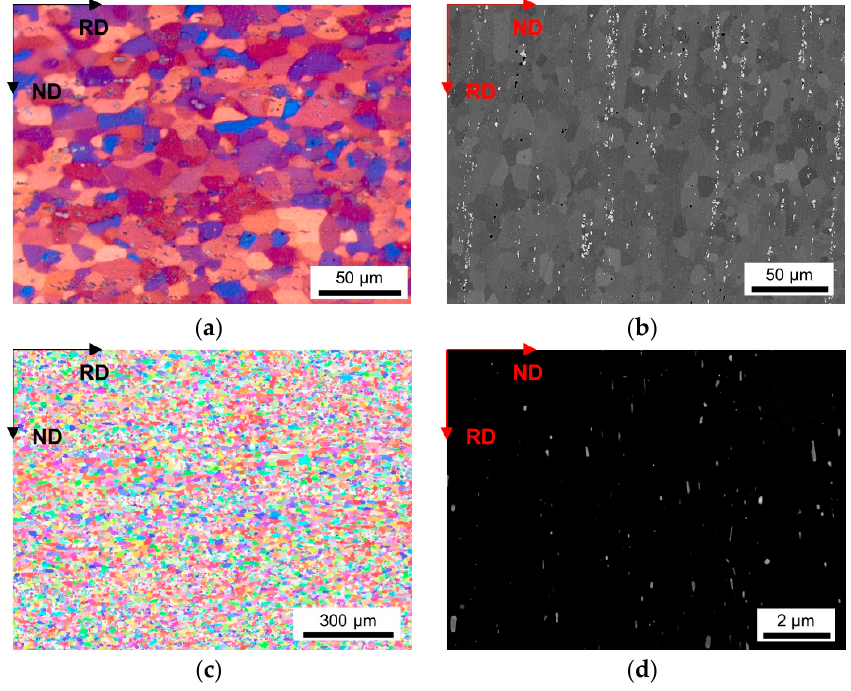
Figure 3. Microstructure of the soft annealed HFe-HMn cast under NR-C condition, homogenized at 500 °C and cold rolled to a CRD of 35%. ( a ) LOM. ( b ) BSE image. ( c ) EBSD IPF map in RD–ND plane. ( d ) BSE micrograph showing dispersoids.